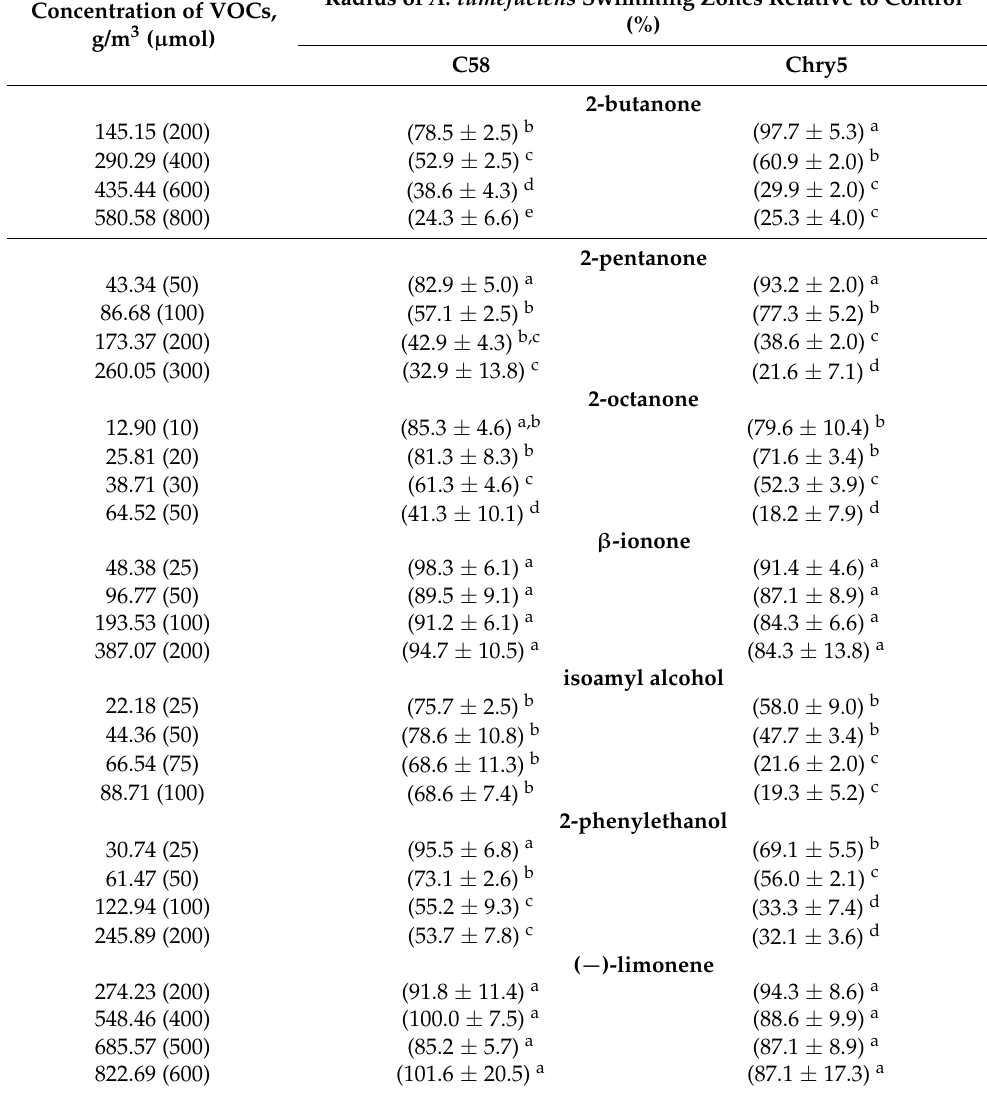
Table 2. Effect of VOCs on A. thaliana swimming motility *. Radius of A. tumefaciens Swimming Zones Relative to Control Concentration of VOCs, (%) g/m 3 ( µ mol) C58